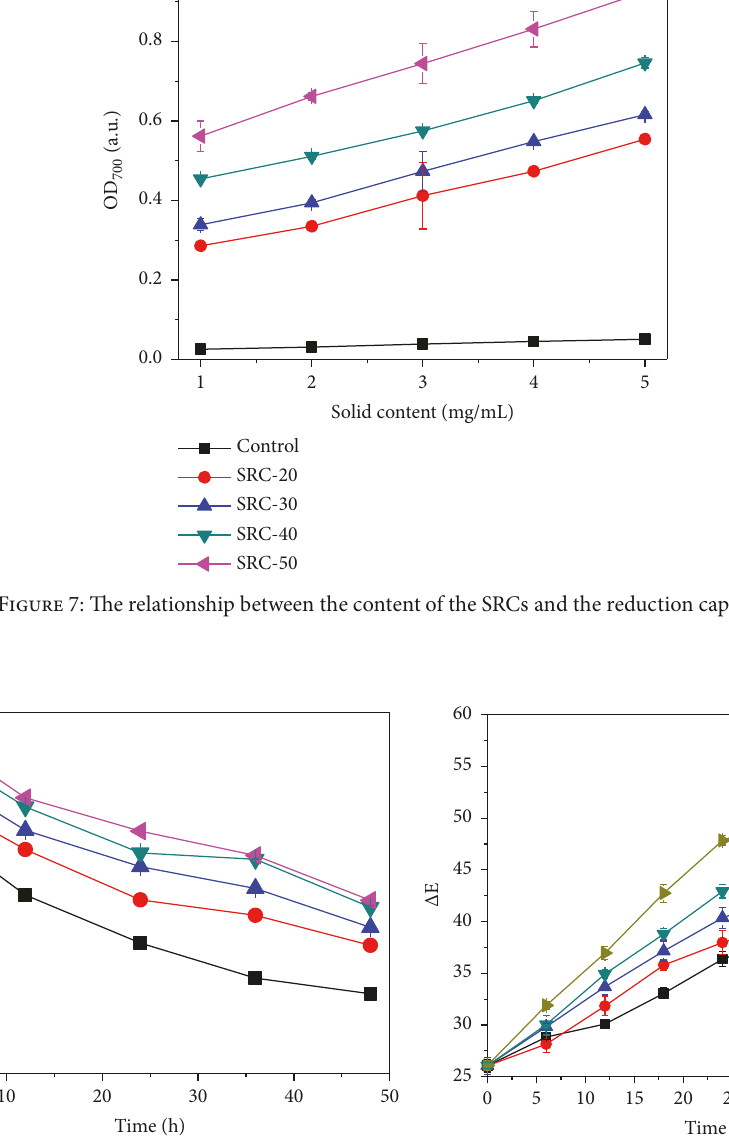
NaIO 4 concentrations, which was beneficial in introducing